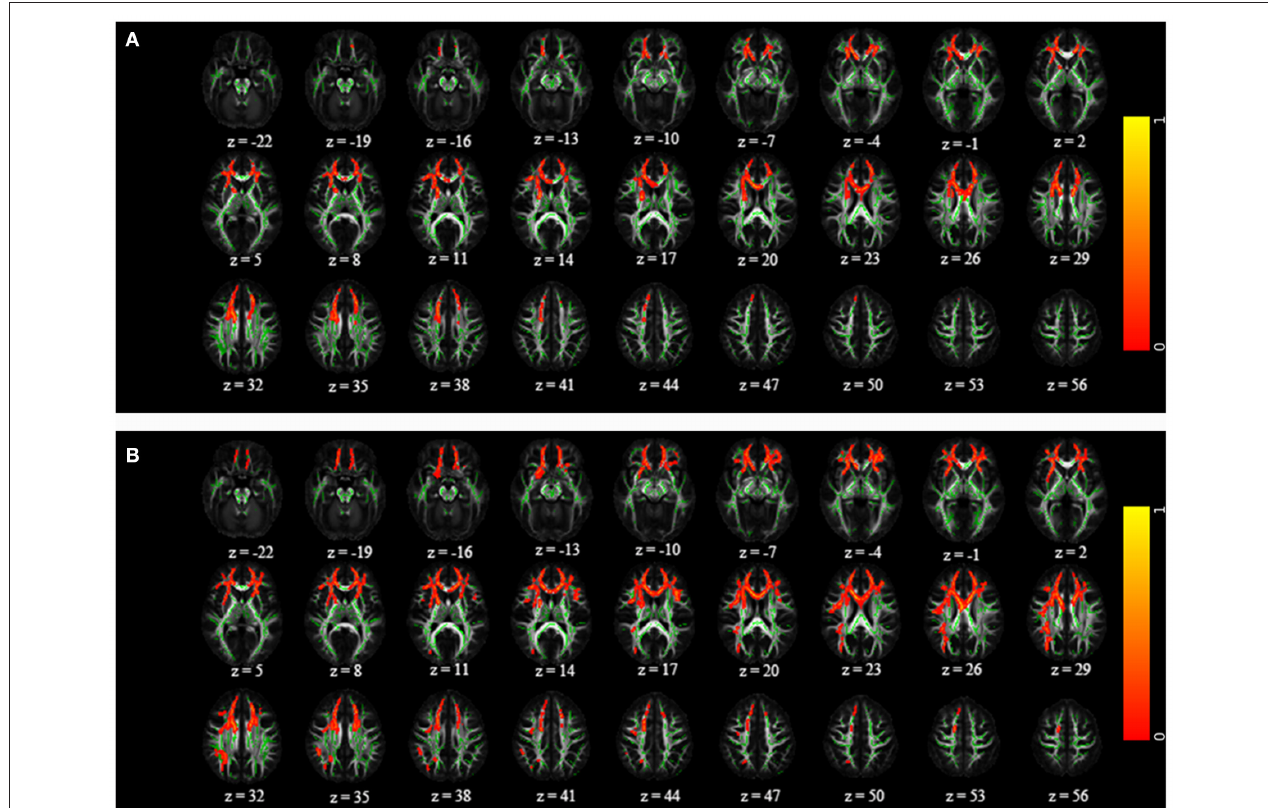
FIGURE 2 | Comparison of statistically significant differences (corrected p < 0.05) between (A) attempters and healthy controls and (B) non-attempters and healthy controls on one axial slice in IIT-mean space. The mean fractional anisotropy (FA) skeleton is shown in green, and regions with higher FA values are shown in red. The color bar provides 1- p